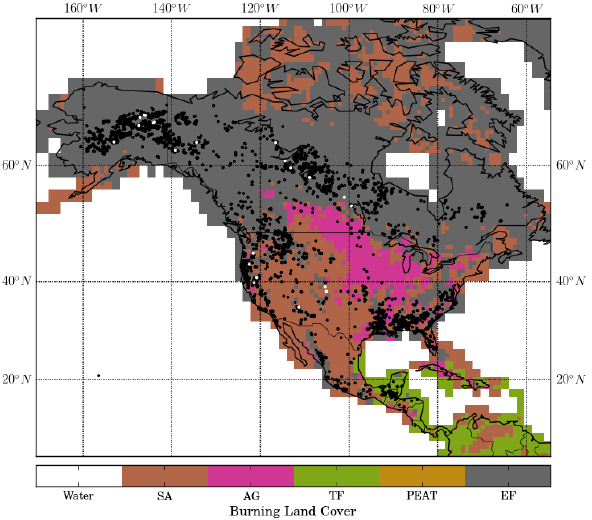
Figure 9. Fire locations contained within the Multi-angle Imag- ing SpectroRadiometer (MISR) plume height data set of Nelson et al. (2013) over North America for the time period 2001–2008 (black dots). White dots indicate the locations of the 22 fires plumes classed as having a plume height in excess of 4 . 5km. The map in the background shows the land cover used within the GFEDv3 biomass burning emissions inventory of van der Werf et al. (2010) where SA, AG, TF, PEAT, and EF stand for savannah, agriculture, tropical forest, peat land, and extra tropical forest respectively.